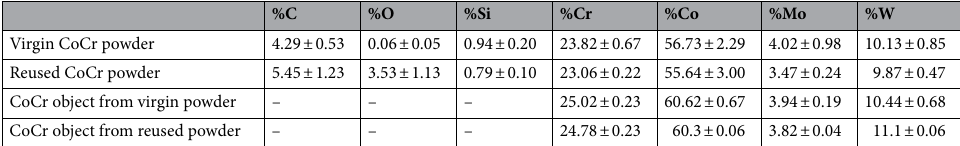
Table 3. Results of EDX analysis on virgin and reused CoCr powder (after sieving) and objects built from these powders. All results are given in weight %.